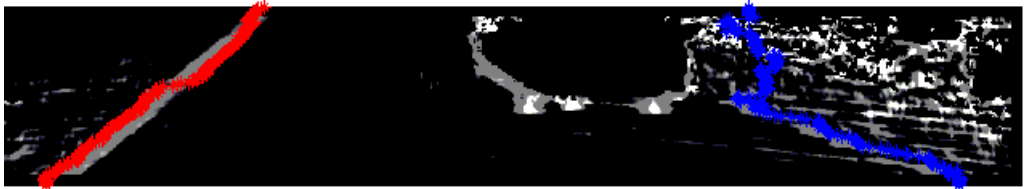
Figure 14. Best path for each side. Red points indicate the left curb, blue points indicate the right